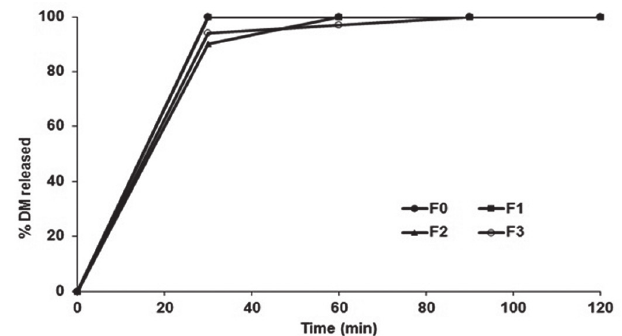
FIGURE 4 ‑ In vitro release profiles of DM from pellets formulations prepared from different EC concentrations.